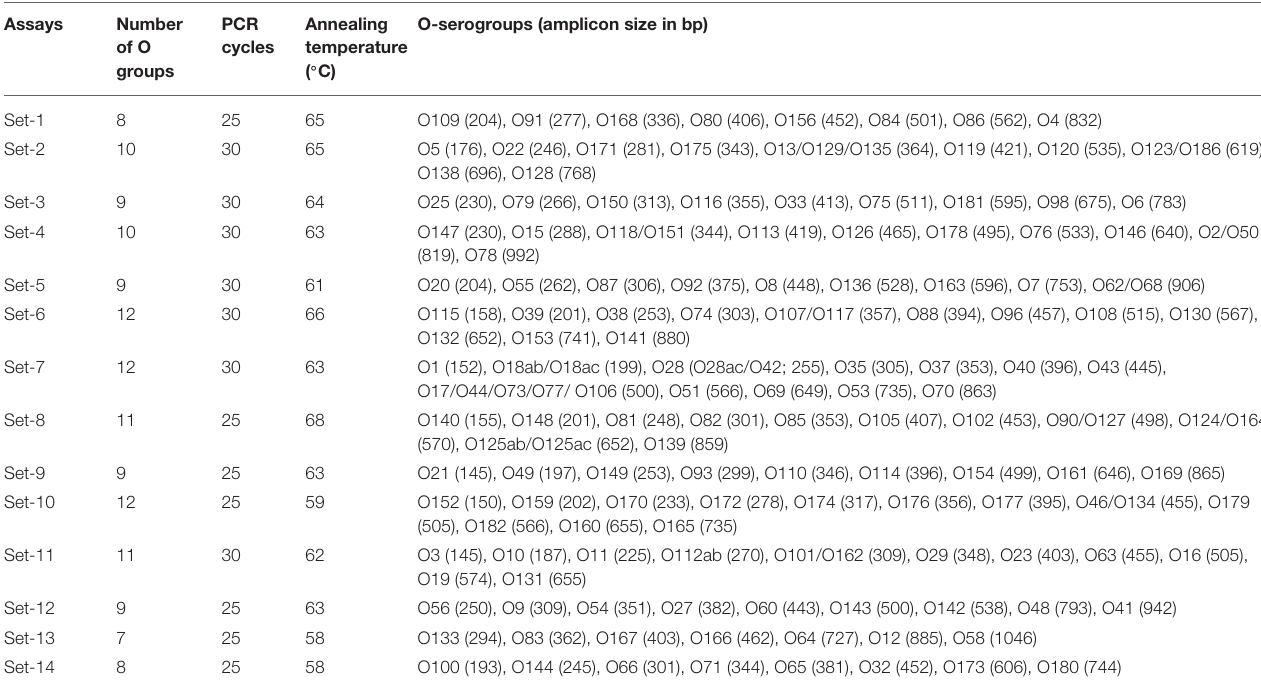
TABLE 3 | Multiplex PCR assays running conditions for the detection of Shiga toxin-producing Escherichia coli (STEC) serogroups, other than top-7 serogroups.